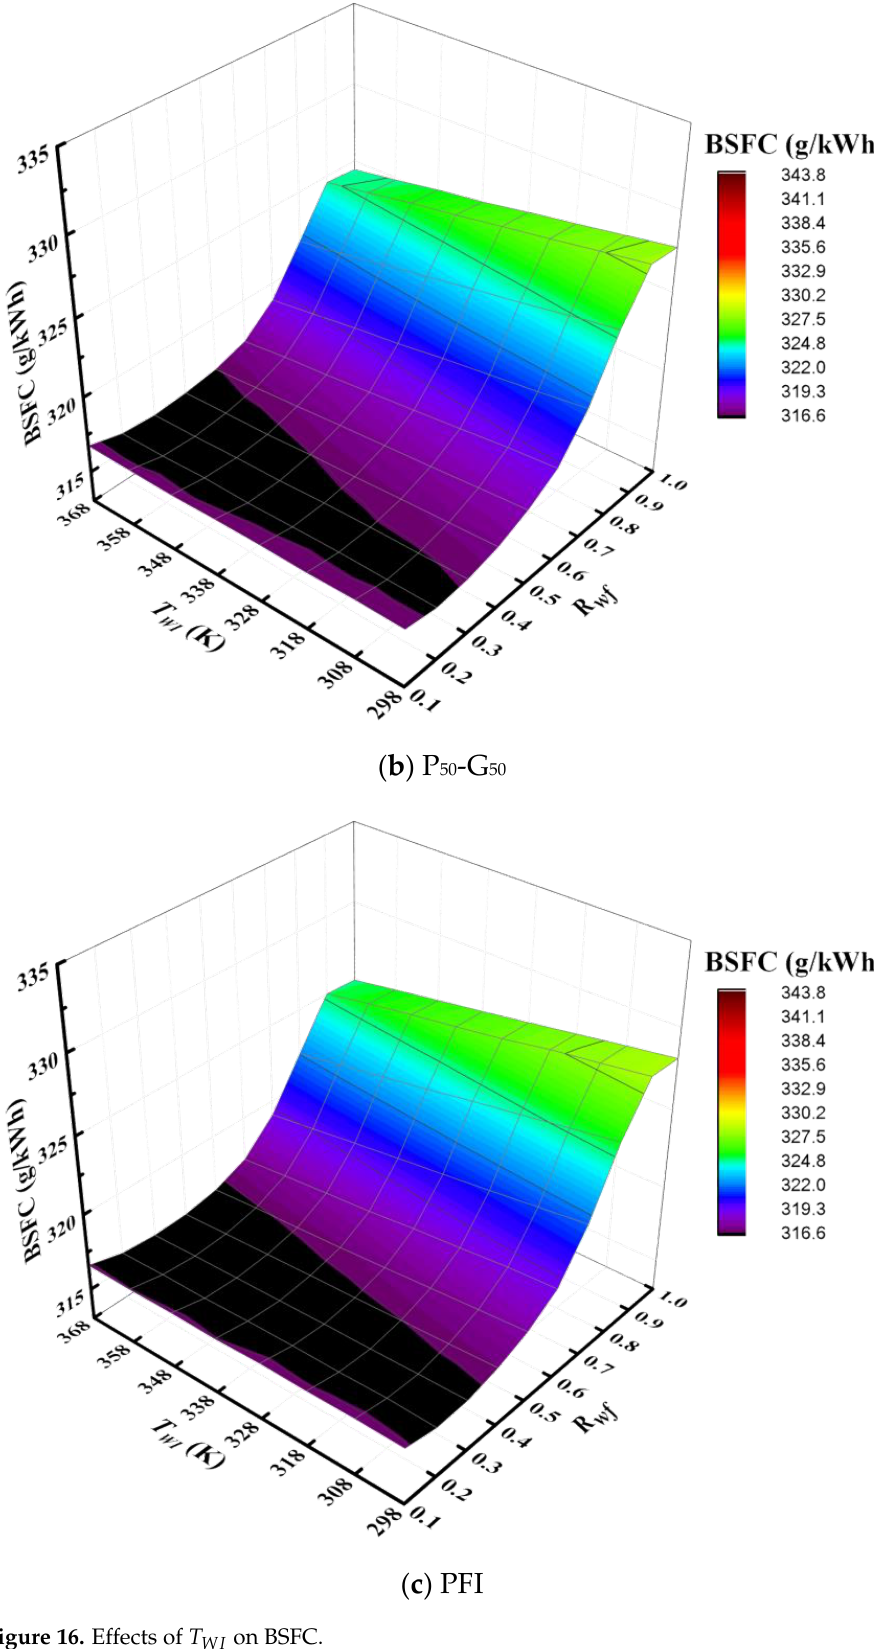
Figure 16. Effects of 𝑇 𝑊𝐼 on BSFC.